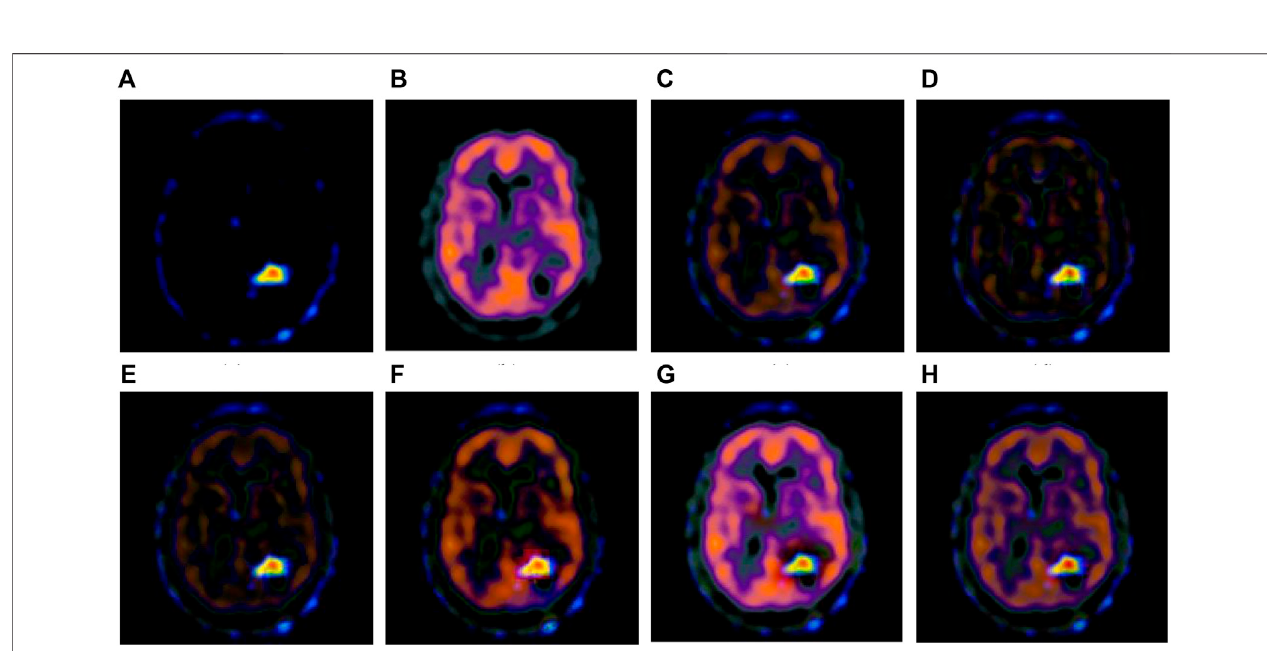
FIGURE 6 | Fusion results of the fourth group. (A) Source image SPECT-TL4 (B) Source image SPECT-TC4 (C) Laplacian Pyramid (D) DWT-DBSS (E) SIDWT- Haar (F) Morphological Difference Pyramid (G) SR (H) GA-SR.